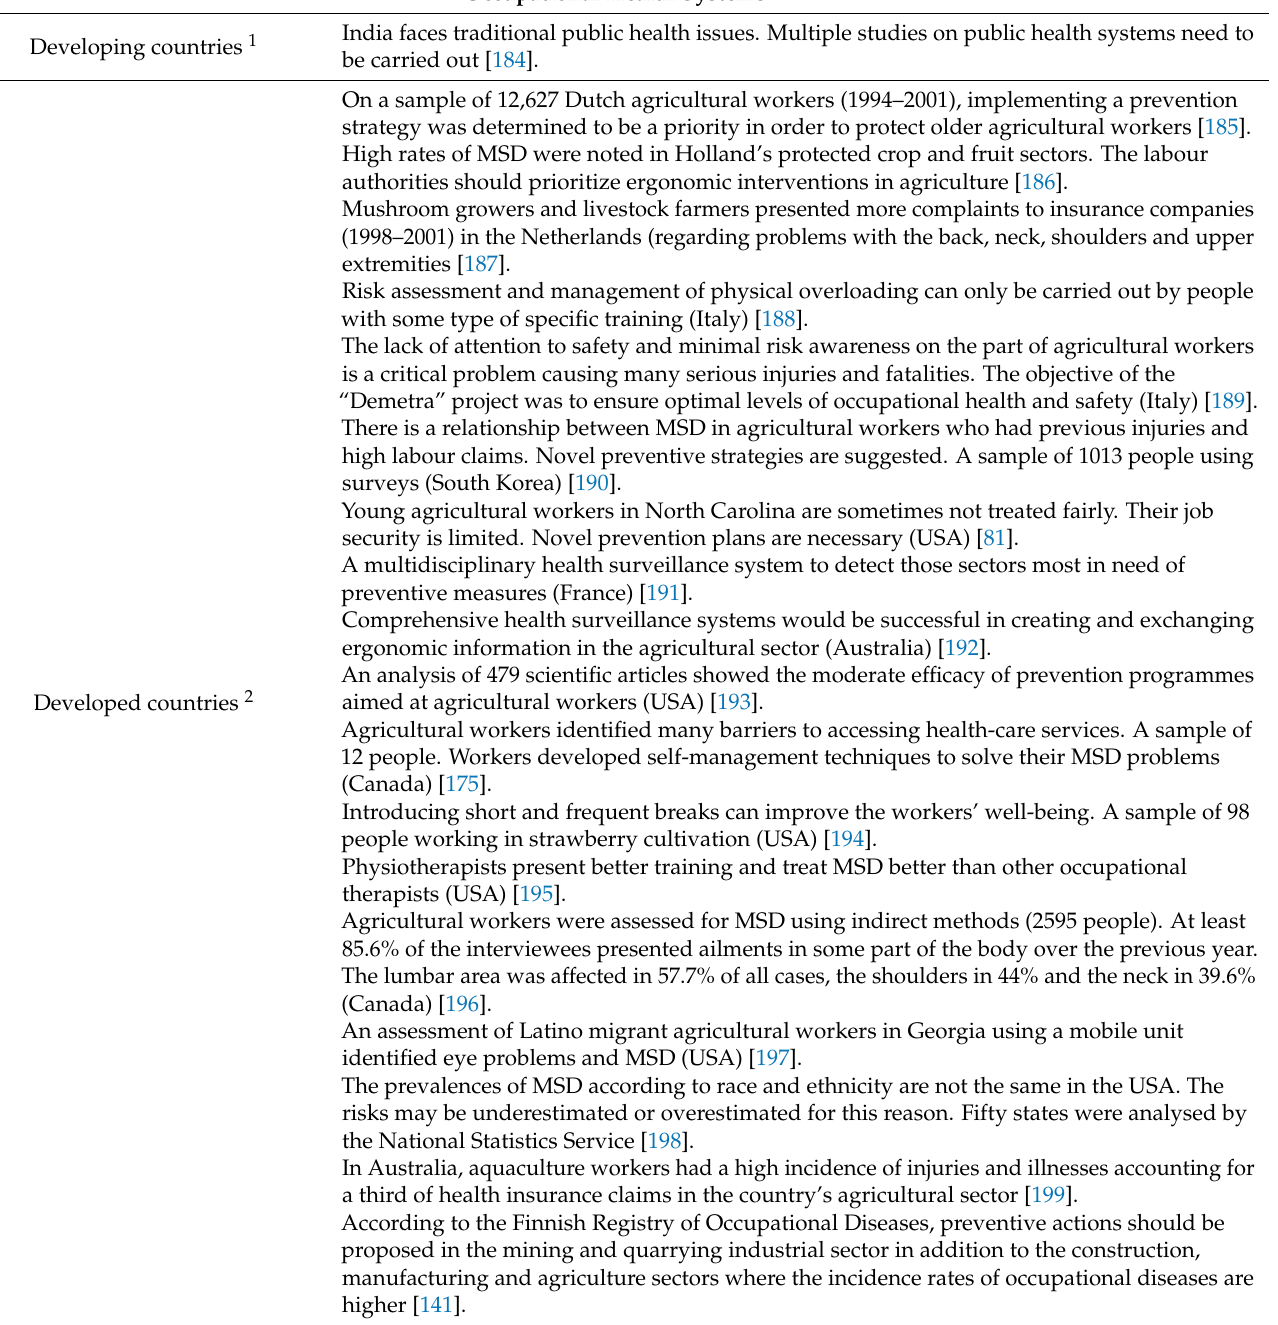
Table A10. MSD research in agriculture (1995–2020). Category: Occupational Health Systems. Occupational Health Systems Developing countries